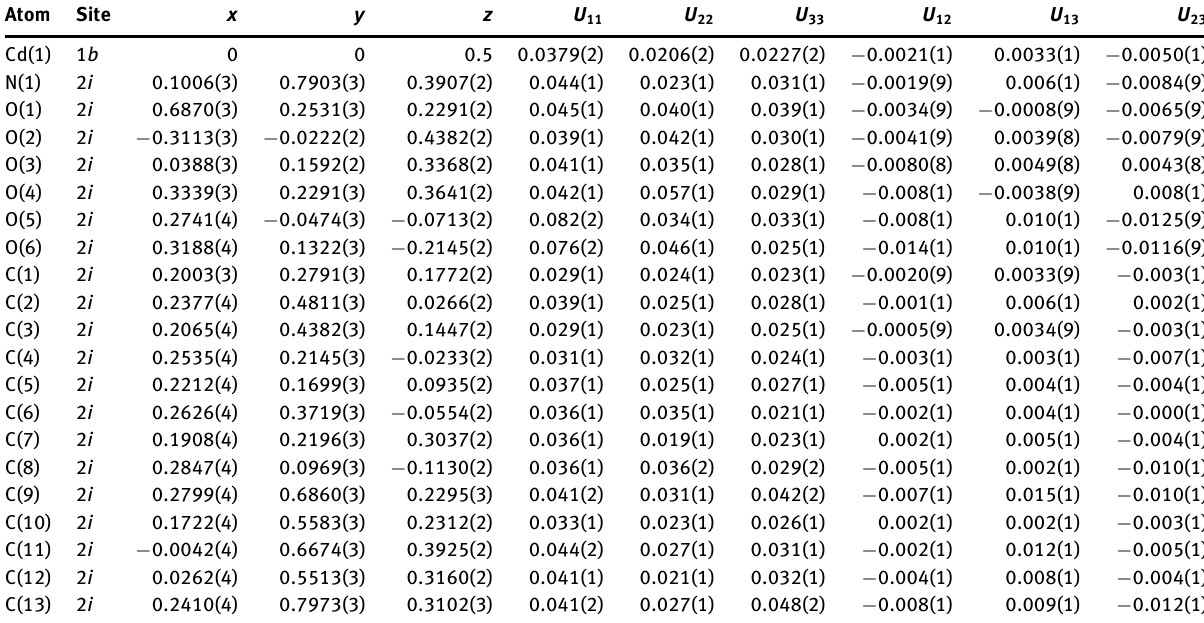
Table 3: Atomic displacement parameters (Å 2